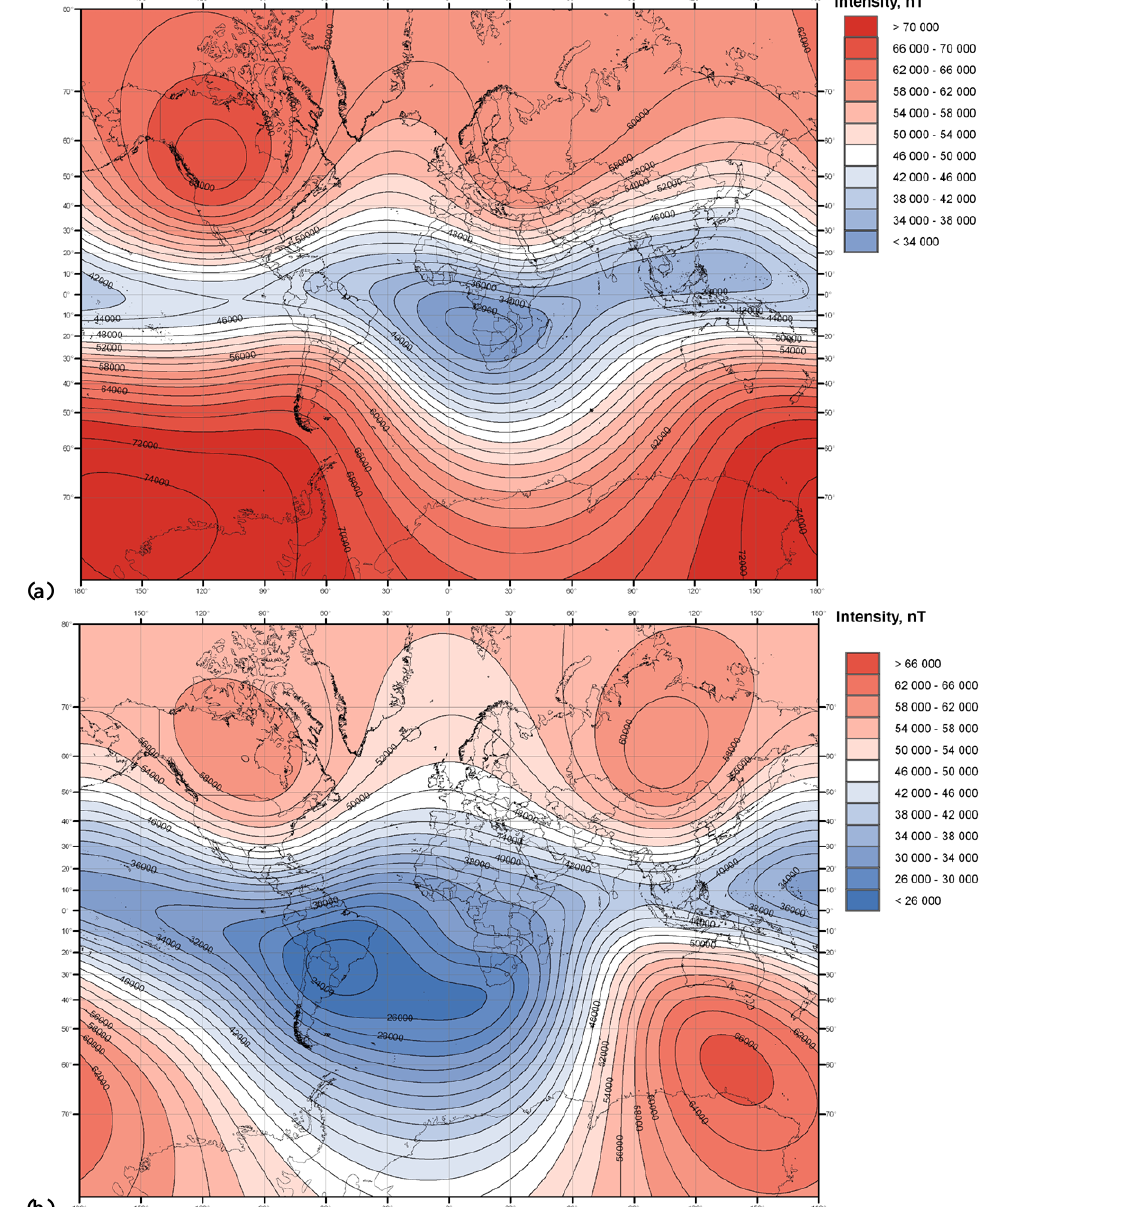
Figure 3. Observed magnetic field fading comparing maps of total intensity isodynams for 1600 (a) and 2000 (b)